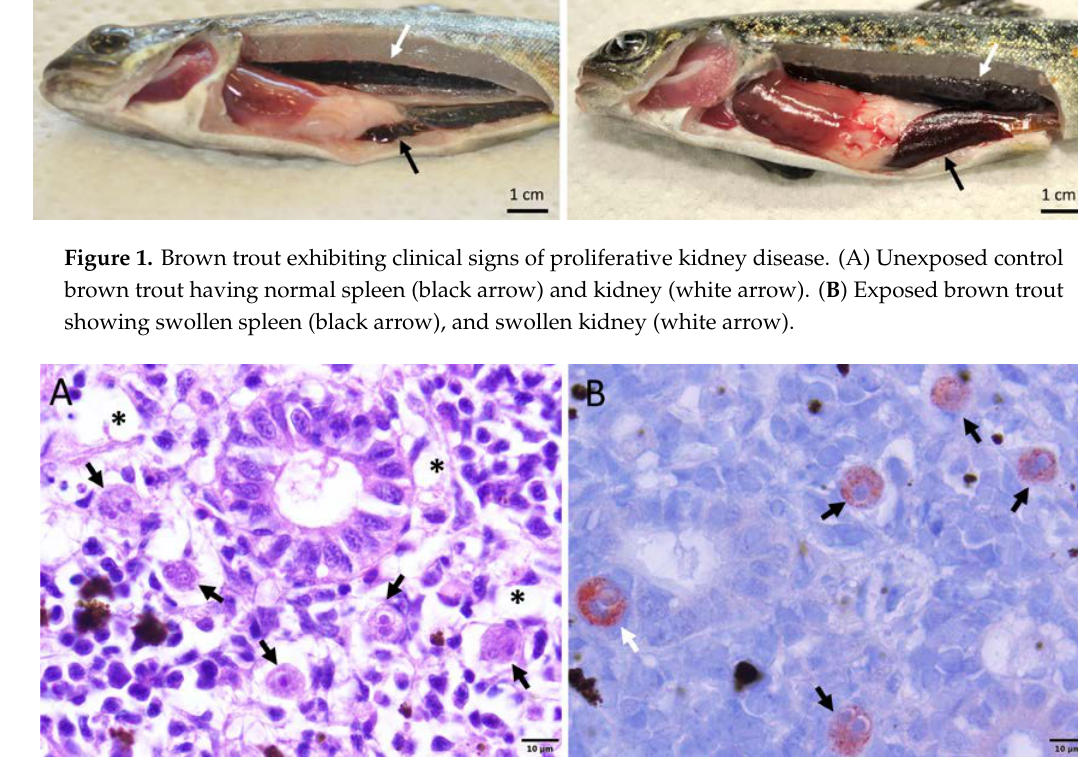
Figure 2. Histopathology and immunohistochemistry of kidney sections. ( A ) Kidney showing renal degeneration (asterisk) and pre-sporogonic stages of the parasite (black arrows) in the renal interstitium. ( B ) Pre-sporogonic (black arrows) and interepithelial stages of the parasite (white arrow). This section was stained using immunohistochemistry and a hematoxylin counter-stain.